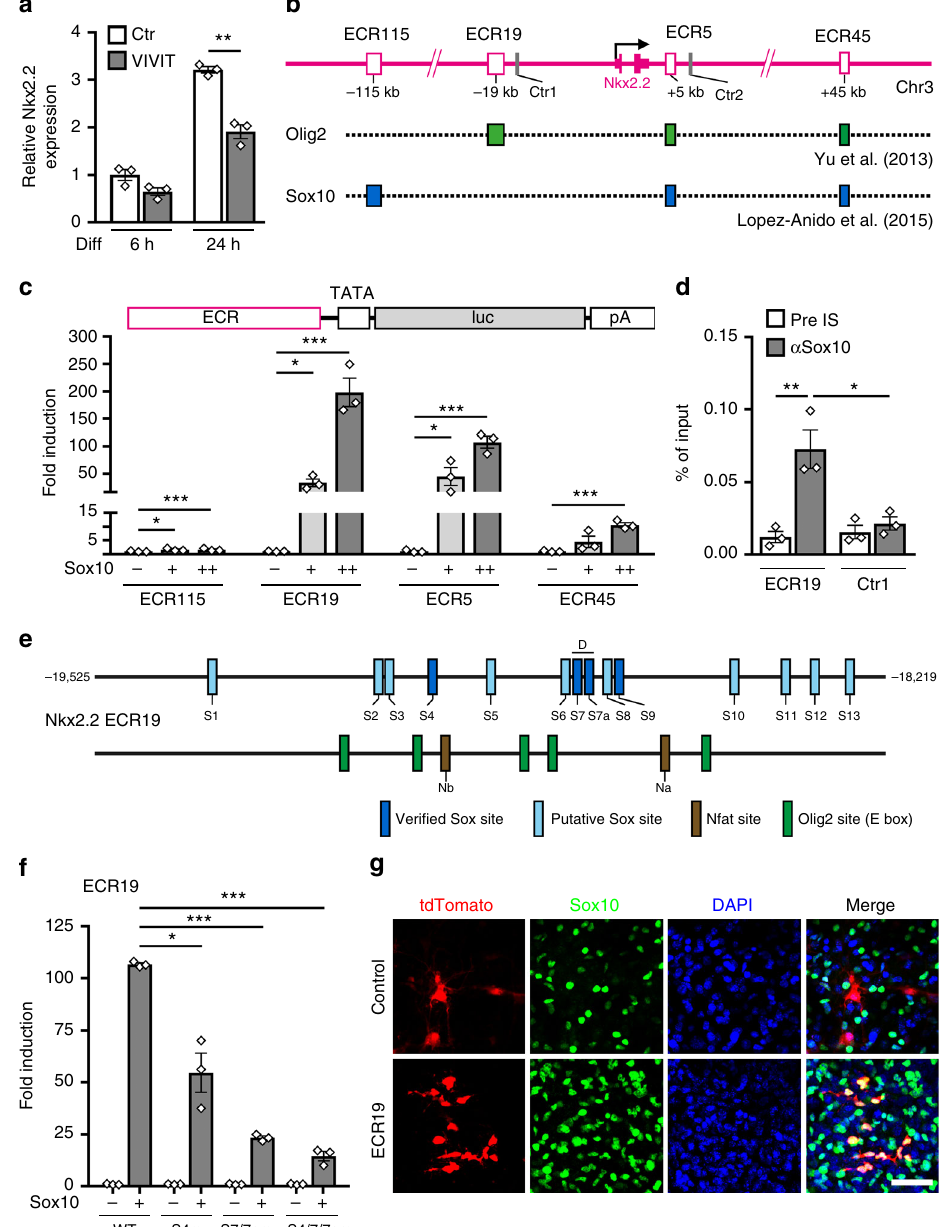
Fig. 4 Sox10 activates oligodendroglial Nkx2.2 expression via ECR19. a QrtPCR analysis of Nkx2.2 expression in mouse oligodendroglial cultures after 6 and 24h differentiation in absence (Ctr, open bars) or presence of 1 µ M VIVIT (grey bars) ( n = 3). Nkx2.2 amounts under control conditions after 6h were set to 1 (values: 1±0.20 for Ctr and 0.65±0.14 for VIVIT after 6h, 3.21±0.12 for Ctr and 1.92±0.25 for VIVIT after 24h). b Rat Nkx2.2 locus with exons (solid pink boxes), ChIP- Seq peaks (GEO accession numbers GSE64703 and GSE42447) for Olig2 (green boxes) and Sox10 (blue boxes) in ECRs (open pink boxes) at − 115, − 19, + 5, and + 45 kilobases relative to the transcriptional start site (arrow) and ChIP control regions (Ctr1 and Ctr2, grey boxes). c N2a cell transfections with luciferase reporters carrying Nkx2.2 ECRs in absence ( − ) or presence of low ( + , light grey bars) and high Sox10 amounts ( ++ , dark grey bars) ( n = 3). Sox10-dependent fold inductions±SEM were determined after 48h with activities in the absence of Sox10 set to 1 (ECR115: 1.6±0.3 at both concentrations; ECR19: 32.9±7.1 and 198.3±26.0; ECR5: 44.6±16.4 and 107.3±10.7; ECR45: 4.5±2.1 and 10.6±0.9). d ChIP on differentiating rat oligodendrocytes after 4 days ( n = 3) using rabbit pre-immune (pre IS, open bars) and anti-Sox10 ( α Sox10, grey bars) antiserum. Amounts of immunoprecipitated ECR19 and control region (Ctr1) were qPCR- determined and are presented as percent of input (ECR19: 0.012±0.004 for pre IS and 0.073±0.013 for α Sox10; Ctr1: 0.016±0.005 for pre IS and 0.021± 0.005 for α Sox10). e Localization of binding sites for Sox10 (putative, light blue; EMSA-con fi rmed, dark blue), Nfat (brown) and Olig2 (green) in ECR19. Numbers on left and right correspond to mouse ECR19 positions relative to transcriptional start site. For EMSA and sequences, see Suppl. Fig. 4c, d. f N2a cell transfections with wildtype (WT) or mutant ECR19 luciferase reporters with inactivated Sox10 binding sites (S4m, S7/7am, and S4/7/7am) in absence ( − ) or presence ( + , grey bars) of Sox10 ( n = 3). Sox10-dependent fold inductions±SEM were determined 48h post transfection (WT: 106.7±0.7; S4m: 54.6±9.1; S7/7am 23.4± 0.9; S4/7/7am 14.6±2.3). g Sox10 immunohistochemistry (green) on cortical slices 7 days after transduction with retroviruses carrying tdTomato reporters (red) under control of a minimal promoter (control) or minimal promoter and ECR19 (ECR19). Co-expression is in yellow, DAPI counterstain in blue. Scale bar, 50 µ m. Statistical signi fi cance was determined by two-tailed Student ’ s t-test (* P ≤ 0.05; ** P ≤ 0.01; *** P ≤